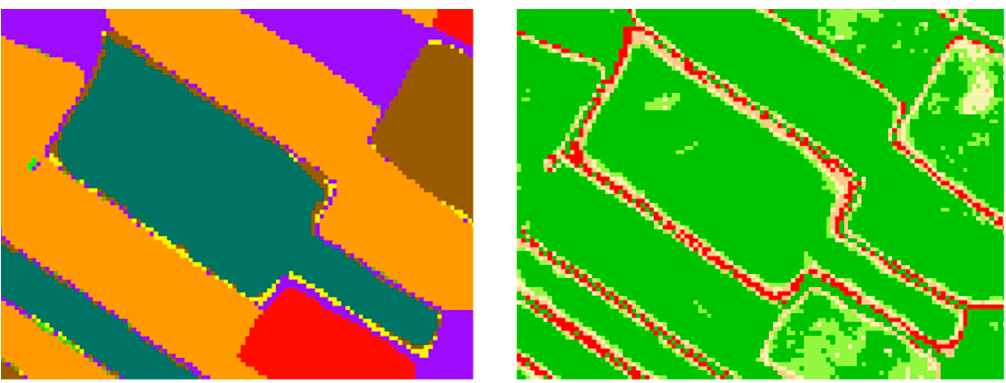
Figure 8. Detail of classification result at the end of August ( left ) and its classification confidence ( right ), demonstrating that the classification confidence near the field borders is significantly lower. In this specific example, the crop class is sugar beet, as correctly classified in the center of the field. The color legends are similar to Figures 4 and 6.